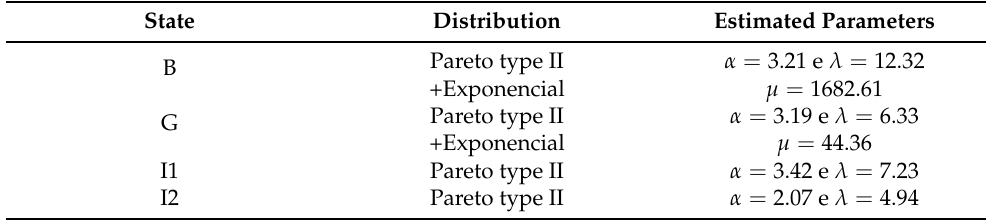
Table 4. Estimated parameters for